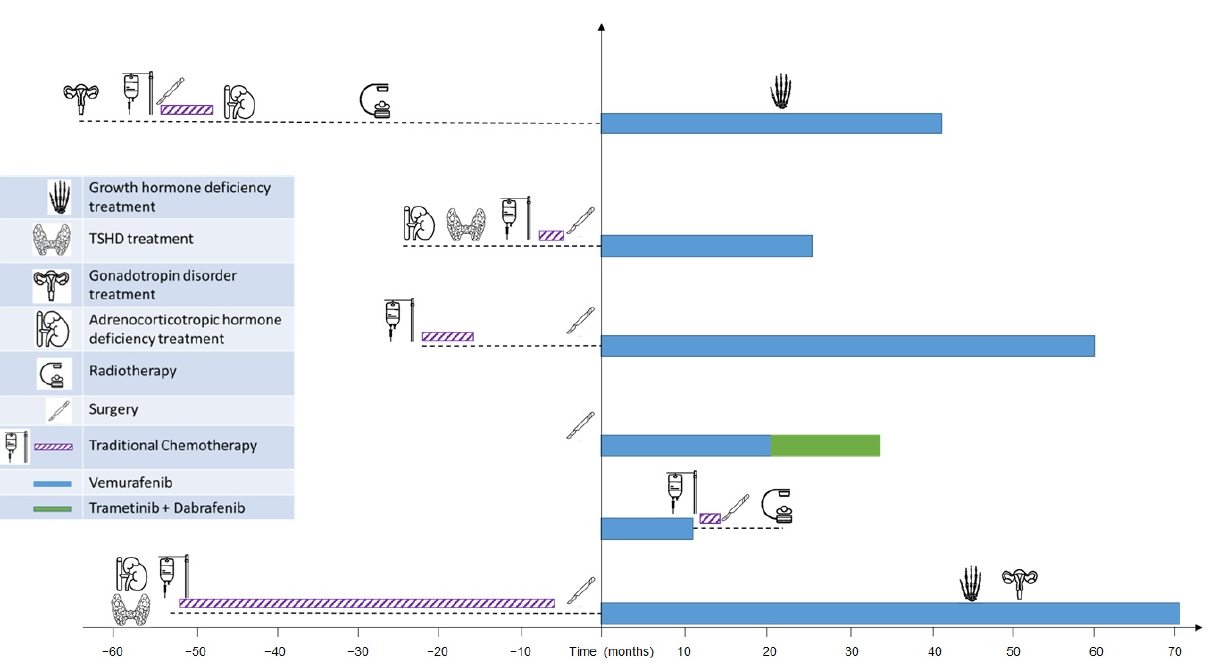
Figure 1. Swimmer plot, endocrinological and oncological